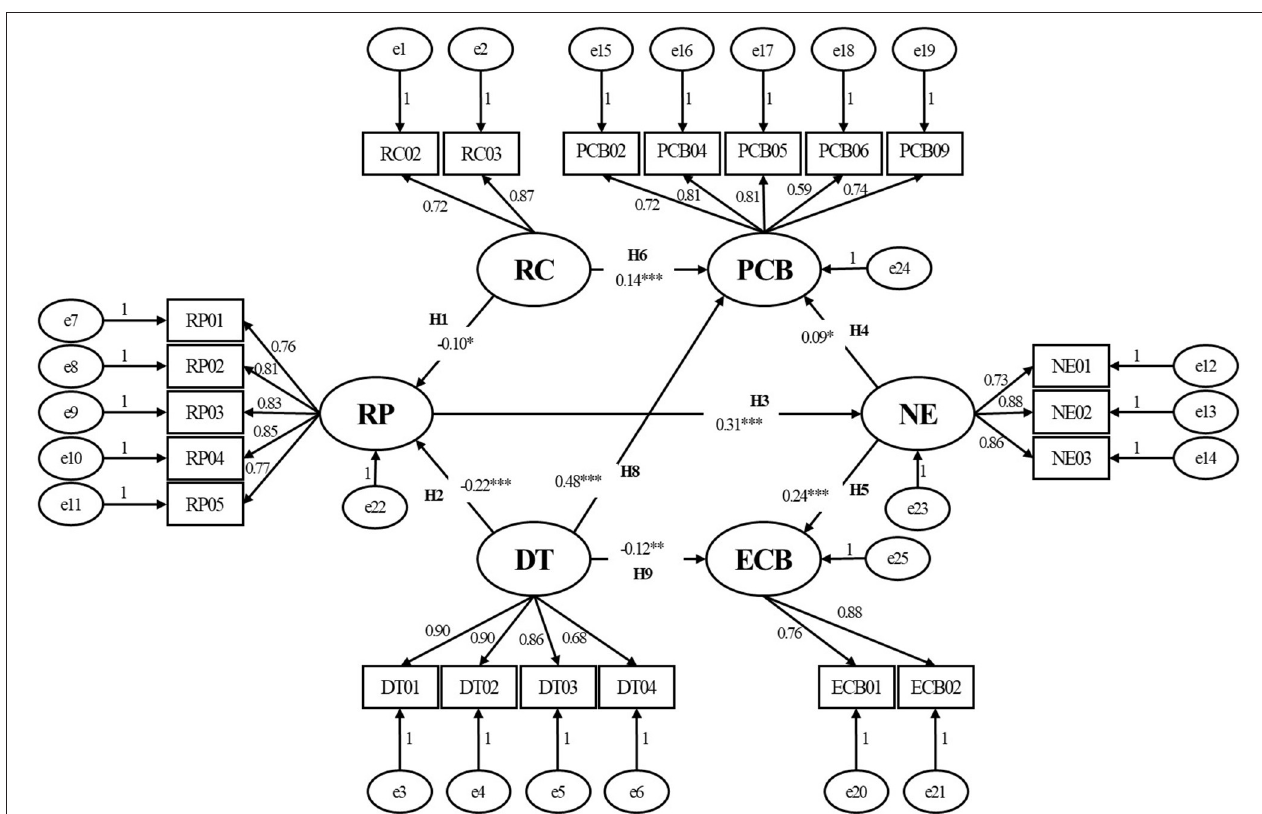
FIGURE 3 | Model 2: The final structural equation model. * p < 0.05; ** p < 0.01; *** p < 0.001. RC, risk communication; DT, degree of trust; RP, risk perception; NE, negative emotions; PCB, protective coping behavior; ECB, excessive coping behavior. The variables e1, e2,..., e25 represent the structure